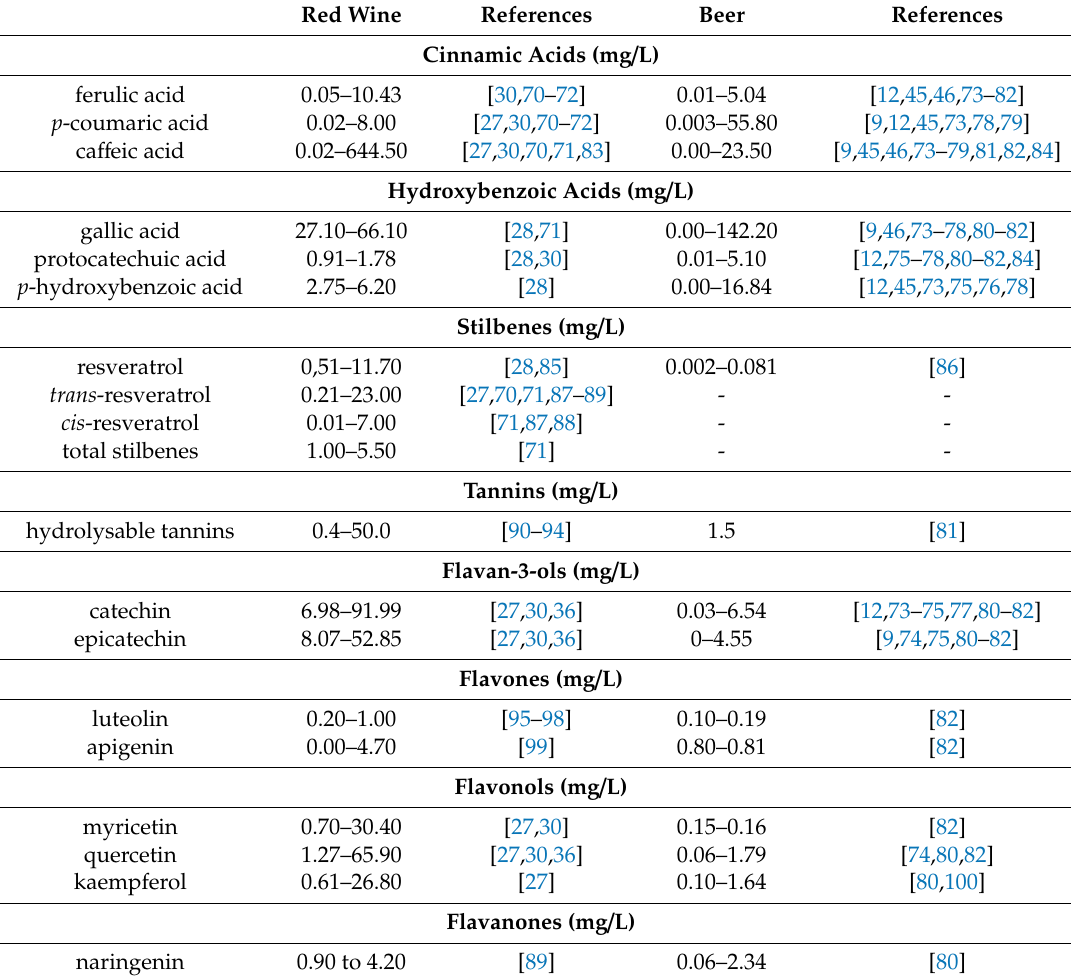
Table 1. Ranges of some phenolic compounds in red wine and